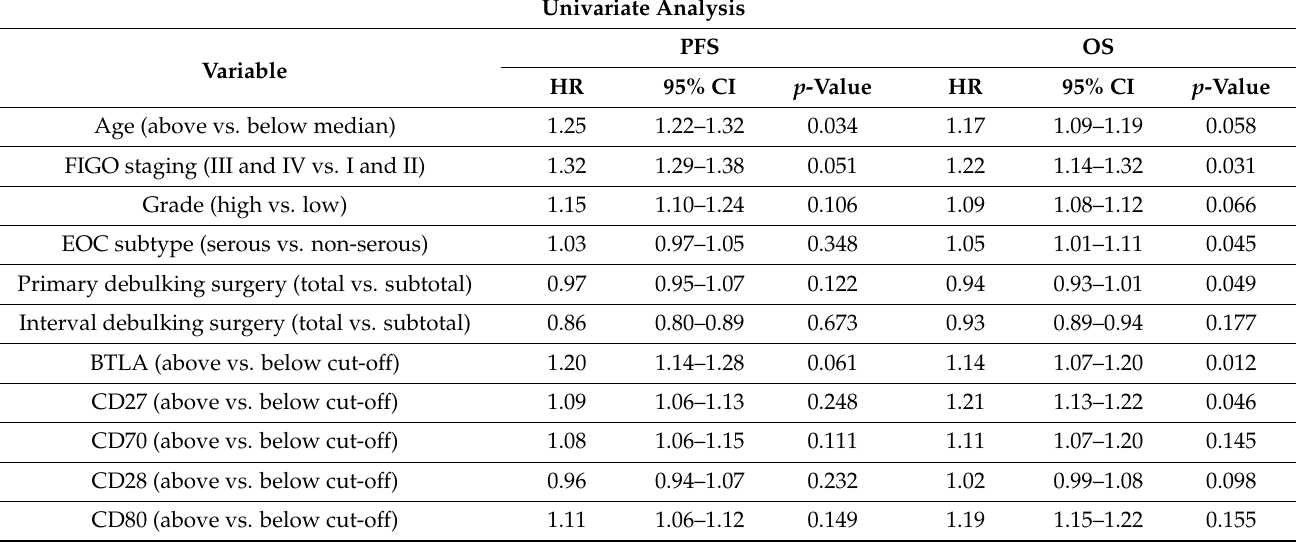
Table 13. Univariate and multivariate Cox regression model for concentrations of studied proteins in peritoneal